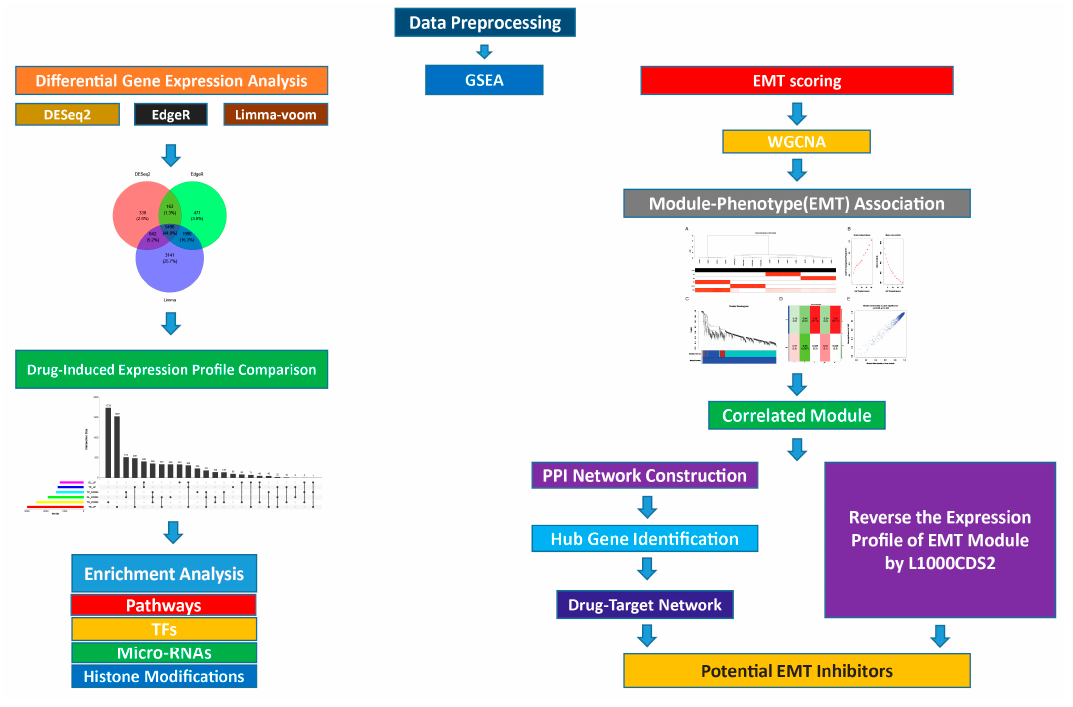
Figure 1. Flowchart of bioinformatics analysis.